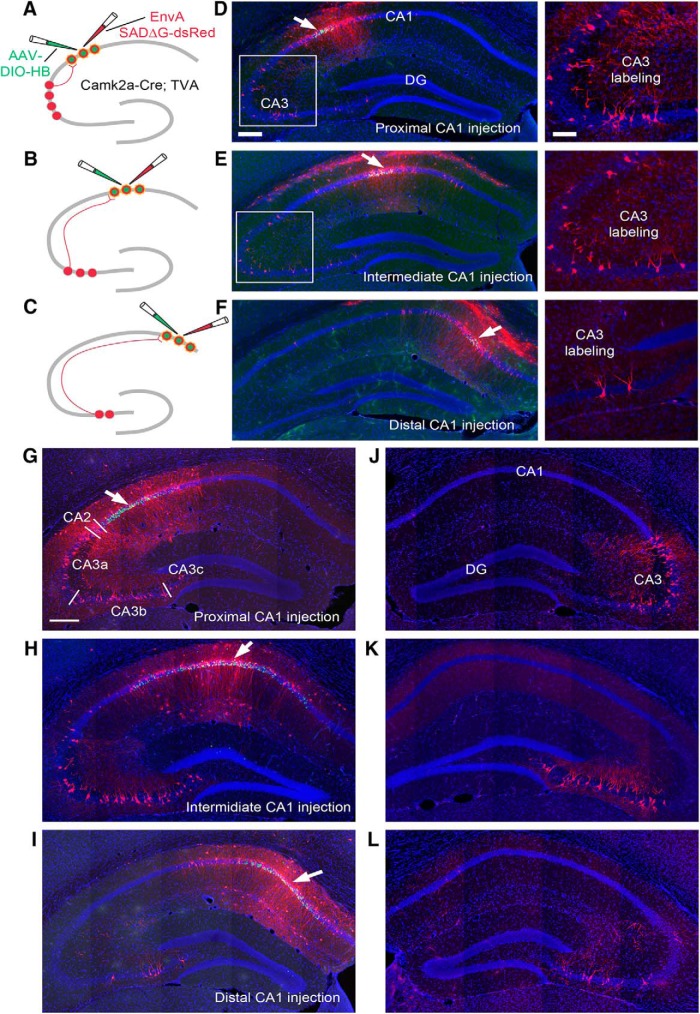
Topographic organization of CA3 to CA1 projections revealed through monosynaptic rabies tracing by specifically targeting CA1 pyramidal cells along the proximal-distal axis. A–C, The schematic illustrates targeting proximal (A), intermediate (B), and distal (C) CA1 through a Cre-dependent rabies tracing system. A Cre-dependent AAV helper virus (AAV8-EF1a-DIO-HB) carrying histone GFP (hGFP) and rabies B19 glycoprotein (B19G) is injected into different CA1 subfields of the Camk2a-Cre; TVA mice. Thus, the AAV helper virus only expresses in CA1 excitatory pyramidal neurons. Three weeks later, an EnvA pseudotyped, glycoprotein deficient rabies virus encoding mCherry fluorescent protein (EnvA-SAD-ΔG-mCherry) is delivered into the same brain region of the AAV injection. Once rabies virus has infected the same group of neurons via the TVA receptor, it undergoes transcomplementation and spreads to the presynaptic partners of the targeted neurons and labels the presynaptic neurons with mCherry (shown in CA3). Note that some mCherry labeling of excitatory neurons around the injection is due to primary rabies infection, as pyramidal neurons expressing TVA can be directly infected by local injection of EnvA-ΔG rabies. Based on laminar position, putative inhibitory cells were labeled outside the pyramidal cell layer. D–F, Examples show the injection sites (pointed by the arrows) in proximal (D), intermediate (E), and distal (F) CA1 by using iontophoretic injections. The corresponding CA3 labeling is shown in the enlarged panels on the right. Brain slices were sectioned coronally. DAPI staining is shown in blue, GFP expression of AAV helper virus is shown in green, and mCherry expression of rabies virus is shown in red. Neurons infected by both AAV and rabies, termed as starter neurons, appear in yellow. Scale bar on the left = 200 μm, right = 100 μm. G–I, Examples show the injection sites (pointed by the arrows) in proximal (G), intermediate (H), and distal (I) CA1, by using pressure injections. CA3 labeling is shown in the same section. Three white bars in G indicate the divisions of CA3a, CA3b, and CA3c (subfields of CA3). The scale bar (200 μm) in G applies to G–L. J–L, Contralateral CA3 projections to proximal (J), intermediate (K), and distal (L) CA1. Also see Fig. 1-1.